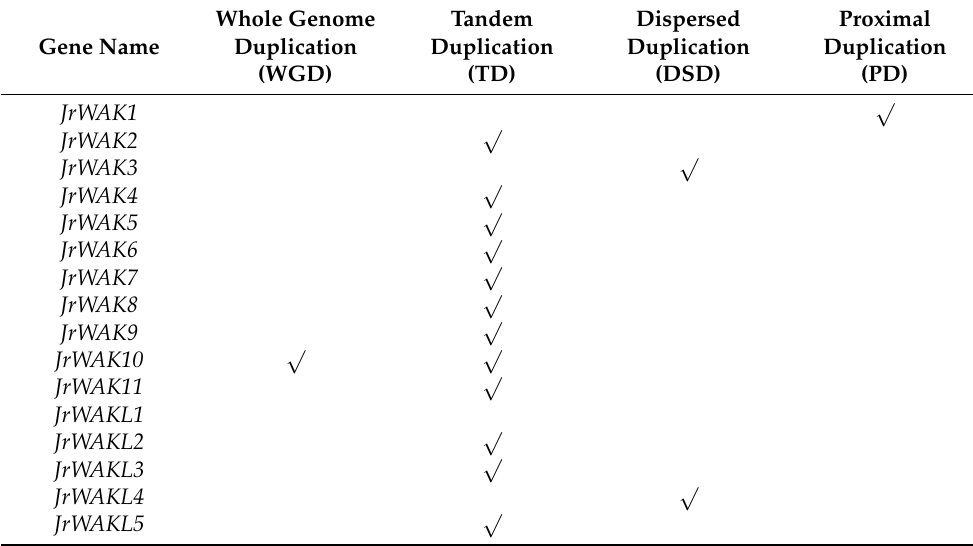
Figure 3. Chromosomal distribution of WAK/WAKL genes. ( a ) Chromosomal distribution of WAK/WAKL genes in J. regia ; ( b ) Chromosomal distribution of WAK/WAKL genes in J. mandshurica . Chromosome numbers were shown below each chromosome. Red, WAK genes; blue, WAKL genes. Green, chromosomes of J. regia ; yellow, chromosomes of J. mandshurica . Table 2. The four duplicated types of WAK/WAKL genes in J. regia and J. mandshurica